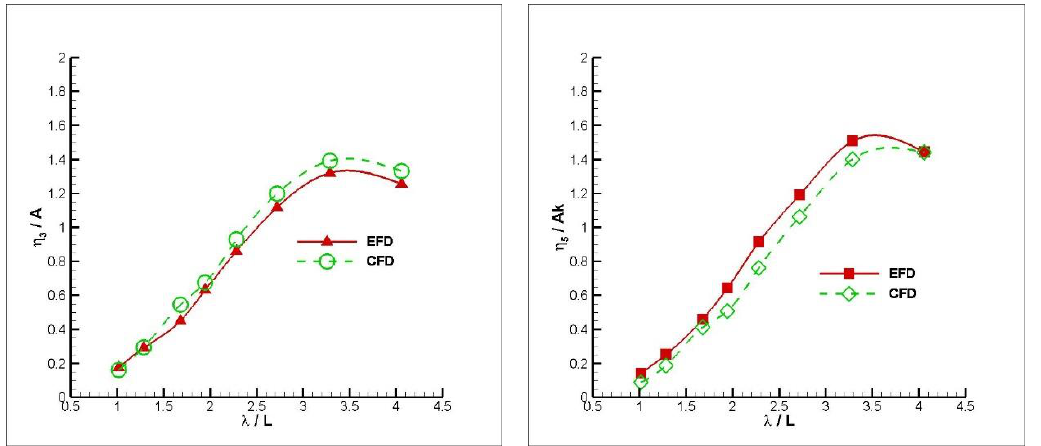
Figure 8. Heave ( left ) and Pitch ( right ) RAOs of the mono hull at Fn B = 2.82.